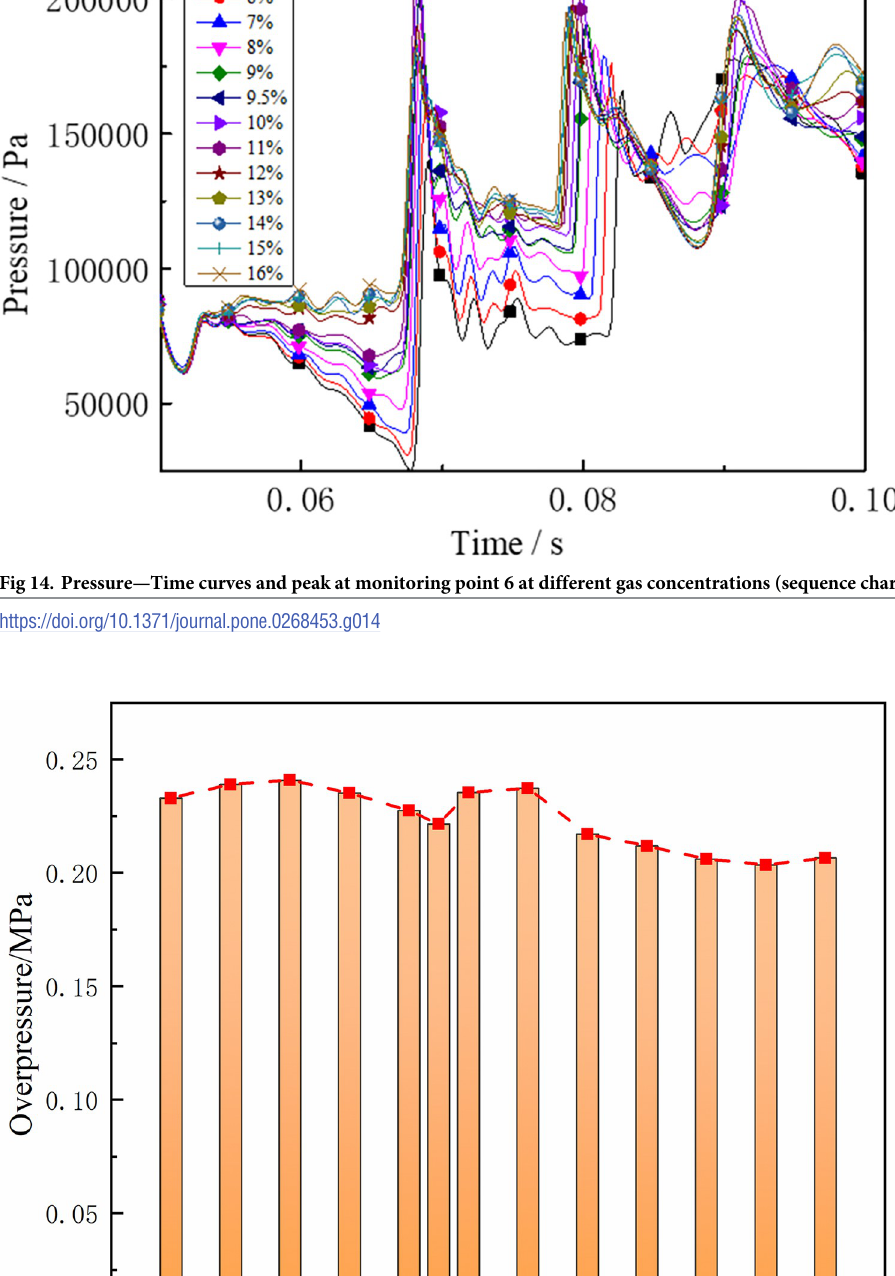
PLOS ONE | https://doi.org/10.1371/journal.pone.0268453 May 26,